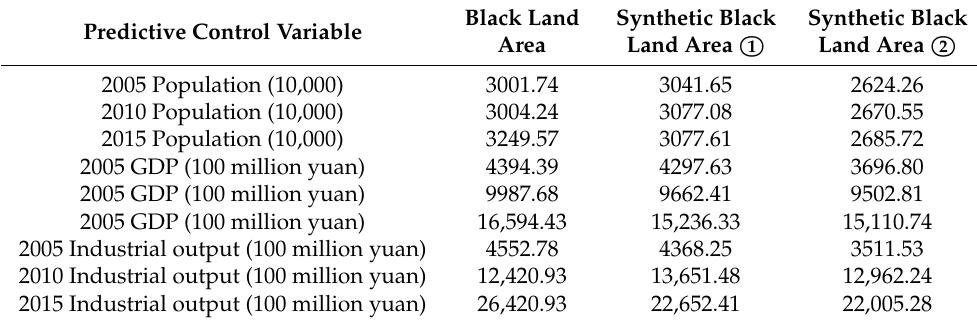
Table 3. Comparison of the variable values of real and synthetic black land areas. Predictive Control Variable